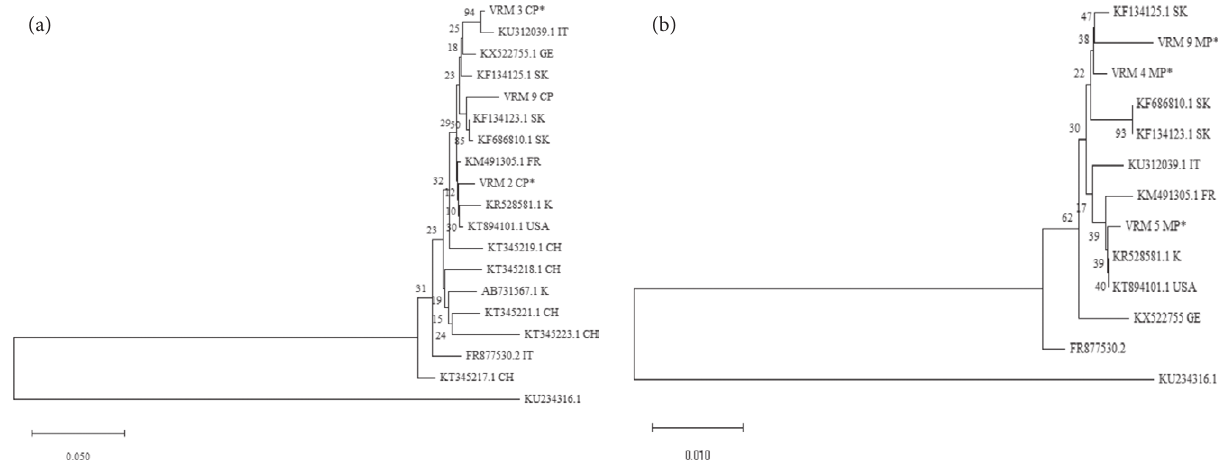
Figure 3. Phylogenetic trees generated from partial nucleotide genome sequences of the coat protein region (a) and movement protein region (b) of GPGV isolates. Bootstrap values were obtained using 1000 replicates. CP and MP sequences of GPGV isolates determined in this study are indicated with an asterisk. The phylogenetic trees were reconstructed using the neighbor joining algorithm implemented in MEGA X. Sixteen isolates from China (CH), France (FR), Italy (IT), Korea (K), Slovakia (SK), Germany (GE) or California (USA) were selected from GenBank database and used to construct the CP dendrogram (a). Nine isolates from Korea (K), France (FR), Italy (IT) or California (USA) were used for the MP dendrogram (b). The GINV sequence (KU234316) was used as the outgroup. The number on each tree node represents the